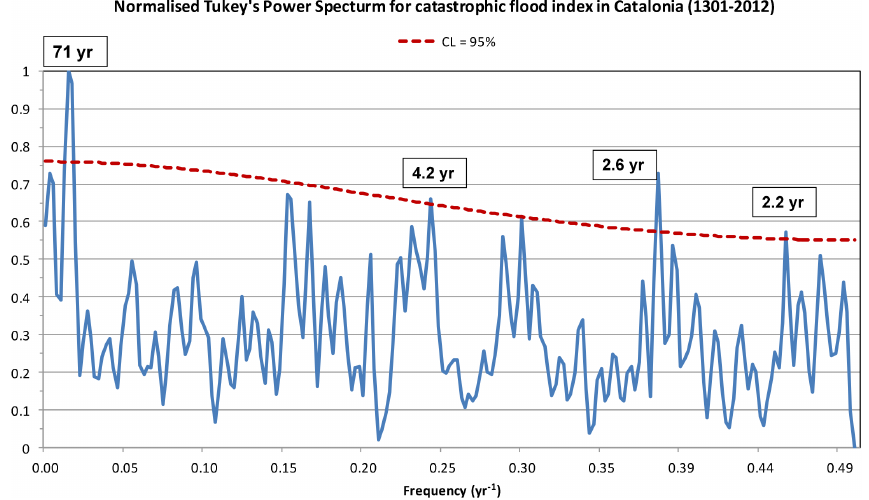
Figure 6. Spectral analysis applied to the catastrophic flood index series for Catalonia (1301–2012) by means of Tukey’s power spectrum. The red dashed line represents the 95% confidence level of the spectral analysis